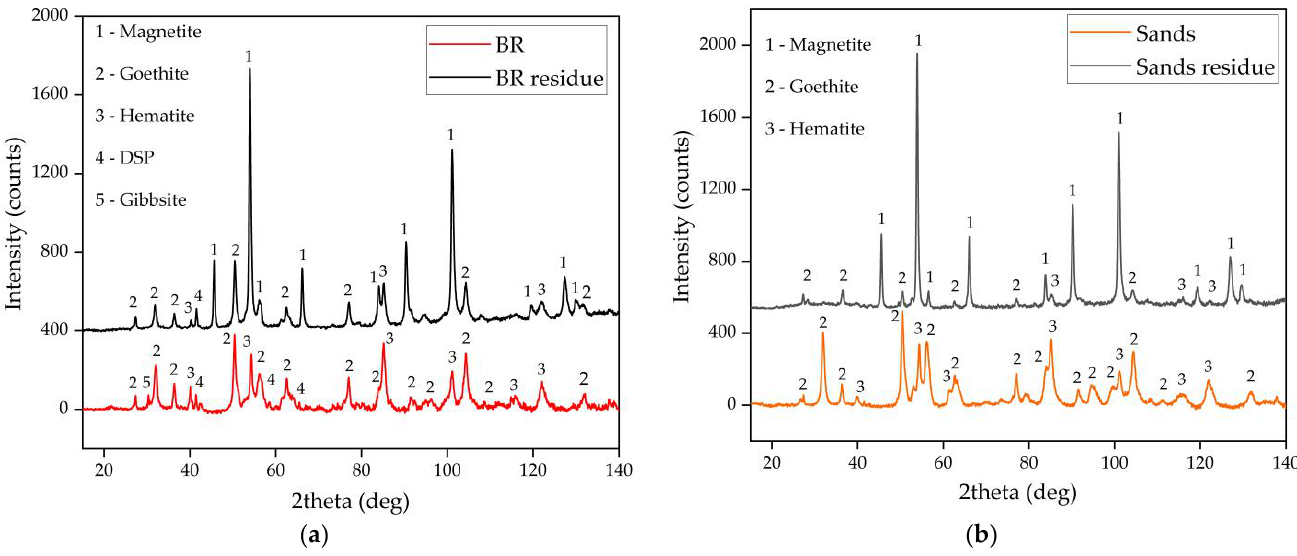
Figure 3. The XRD patterns of the BR and the solid residue obtained after BR leaching under optimal conditions ( a ) and the XRD patterns of the sands and the solid residue obtained after sand leaching under optimal conditions ( b ).